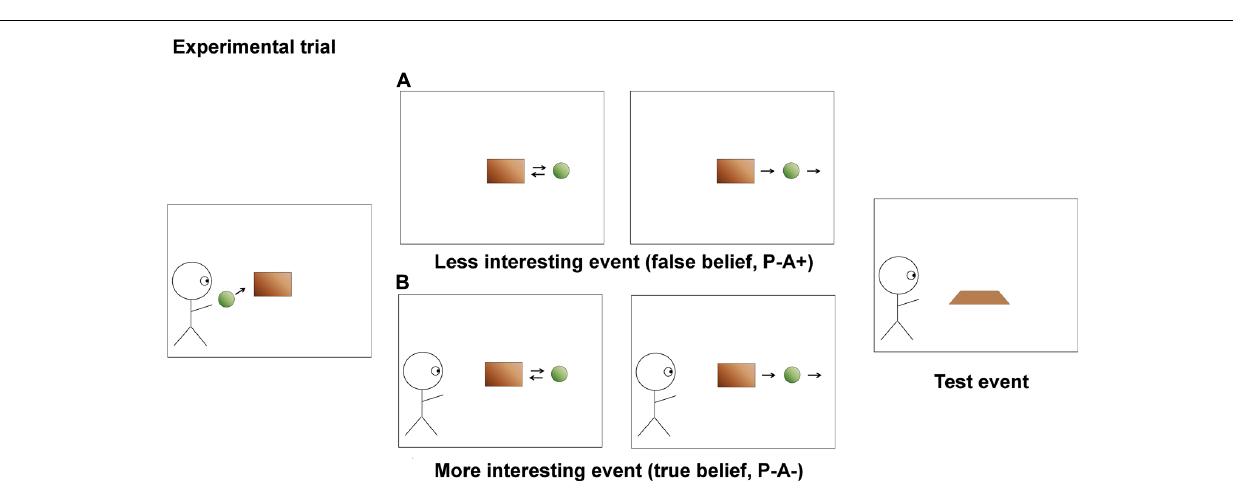
panel, the infants in condition (B) will have a stronger memory of the events, leading to shorter looking time compared to the infants in condition (A) . The condition names in parentheses are from Kovács etal. (2010)